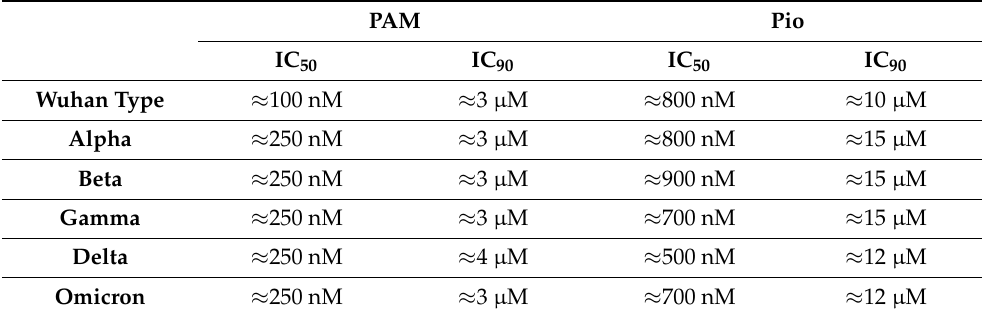
Table 1. IC 50 and IC 90 values of PAM and Pio against SARS-CoV-2 Wuhan type and all VoCs in Calu-3 cells. PAM